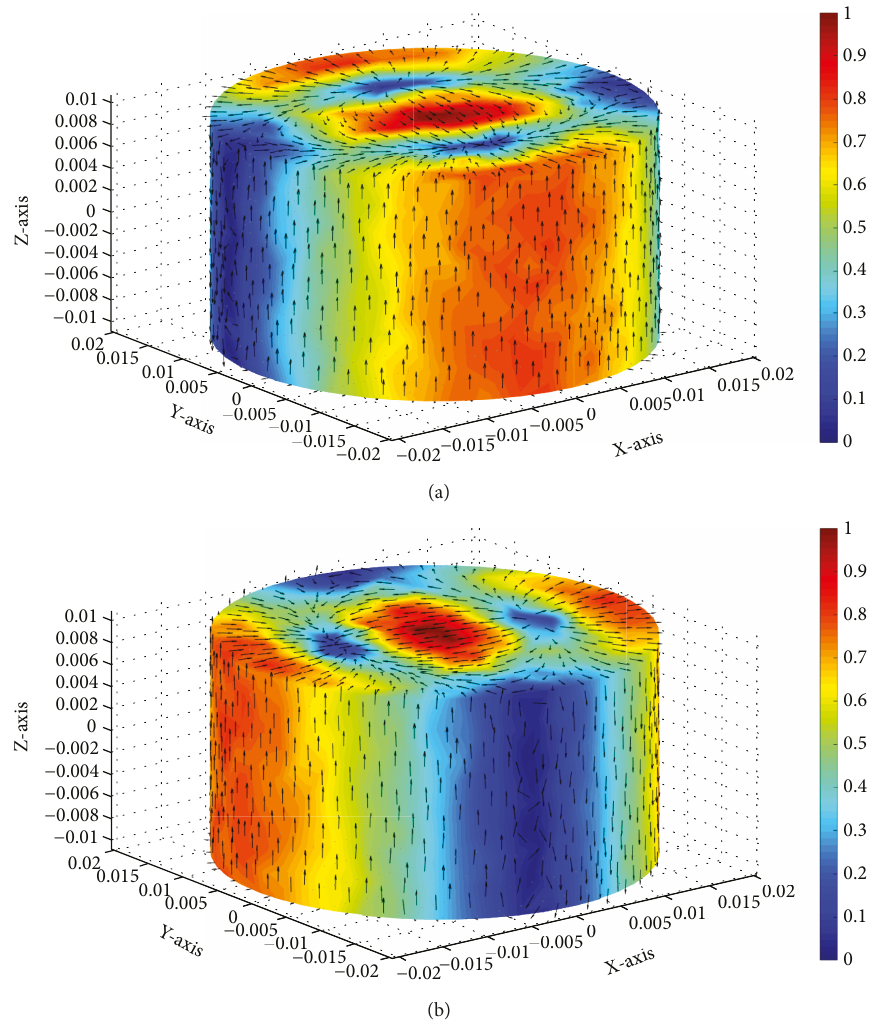
Figure 14: The distributions of the modal currents corresponding to all degenerate nonradiative CMs at 9.15GHz.